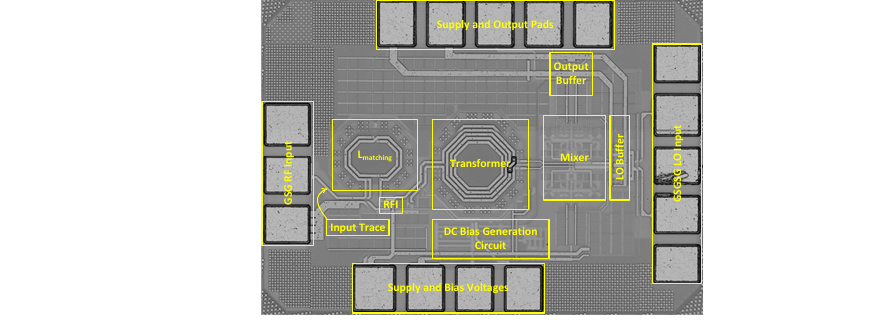
Figure 15. Chip micrograph.